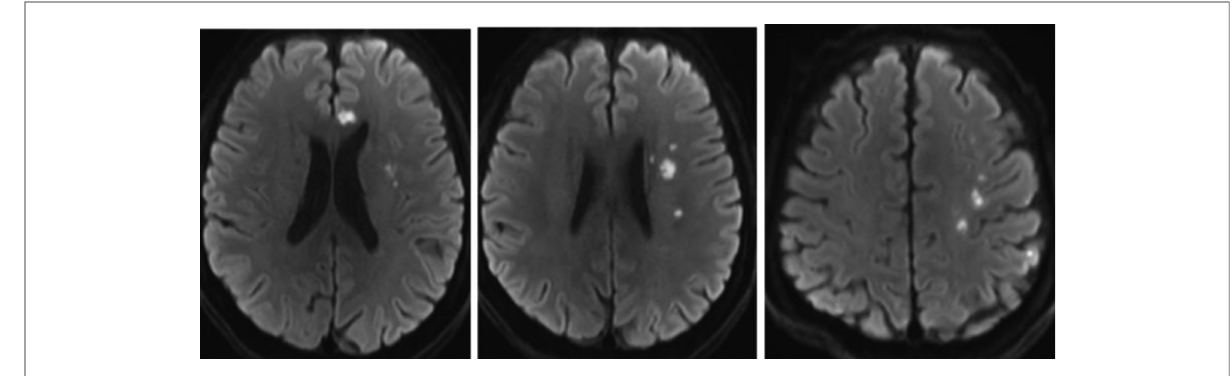
FIGURE 1 Admission brain magnetic resonance imaging showing acute cerebral